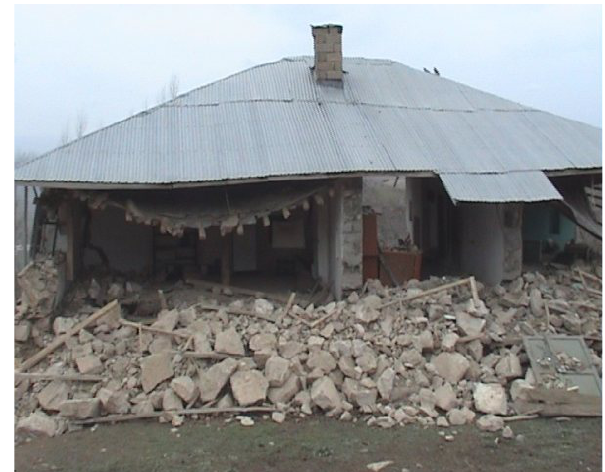
Fig. 5. Heavy roofing with wooden skeleton.